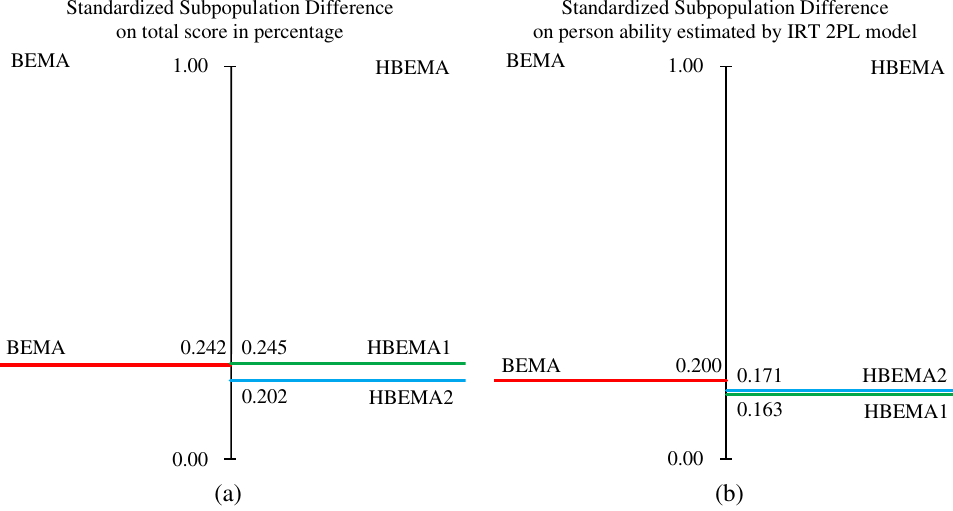
FIG. 4. Standardized mean differences between DS2 and DS3 for the three CIs on (a) total score in percentage and (b) on person ability estimated by IRT